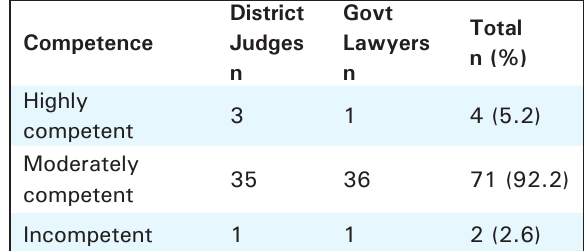
Table 4. Competence of general medical witness in the court of law (n=77).